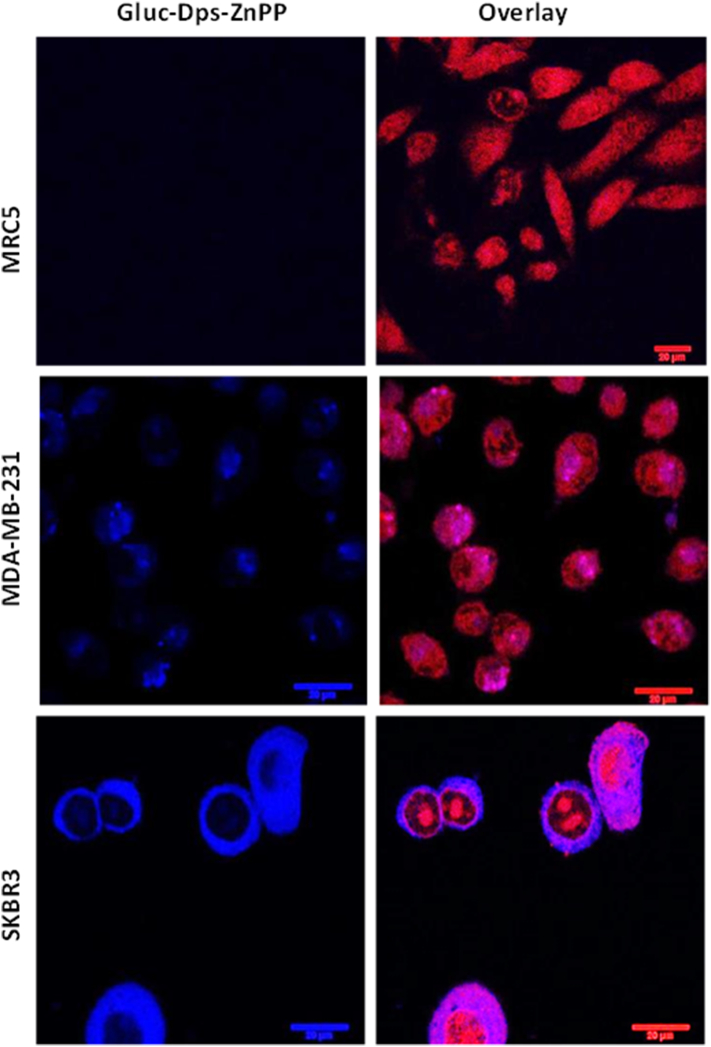
Confocal images of MRC5, MDA-MB-231 and SKBR3 cells demonstrating uptake of Gluc-LiDps-ZnPP after 6 h incubation; blue fluorescence is indicative of the Gluc-LiDps-ZnPP, red fluorescence is indicative of DRAQ5 DNA stain; the overlay of Gluc-LiDps-ZnPP and DRAQ5 in the second column is shown that the Gluc-LiDps-ZnPP is primarily localized in the cytoplasm. Scale bar in all images in 20 μm.